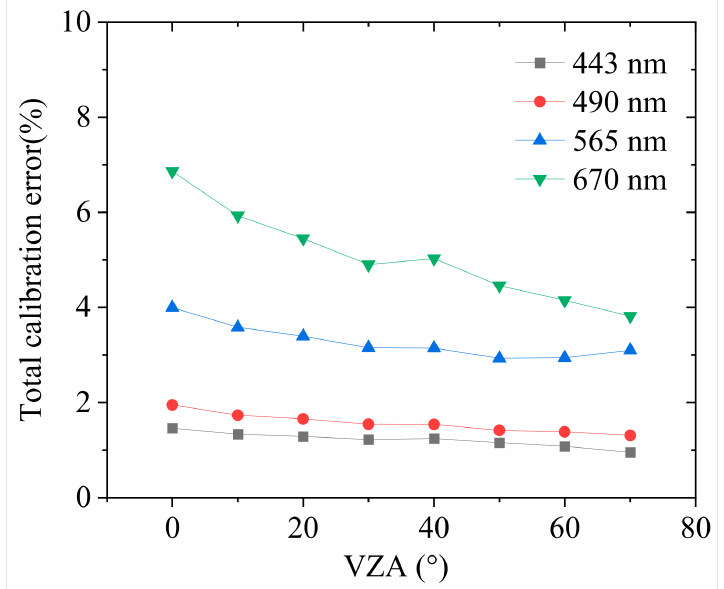
Figure 3. Total Rayleigh calibration error varying with the view zenith angle of DPC at four visible bands (i.e., 443, 490, 565, 670